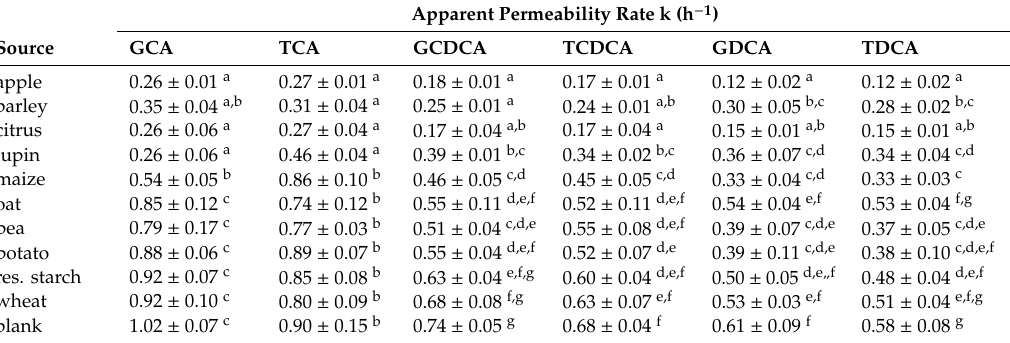
Table 3. Apparent permeability rate constants (k) of kinetic bile acids release analysis (glycocholic acid (GCA), taurocholic acid (TCA), glycochenodesoxycholic acid (GCDCA), taurochenodesoxycholic acid (TCDCA), glycodesoxycholic acid (GDCA), taurodesoxycholic acid (TDCA)) of dietary fibre enriched food ingredients derived from di ff erent